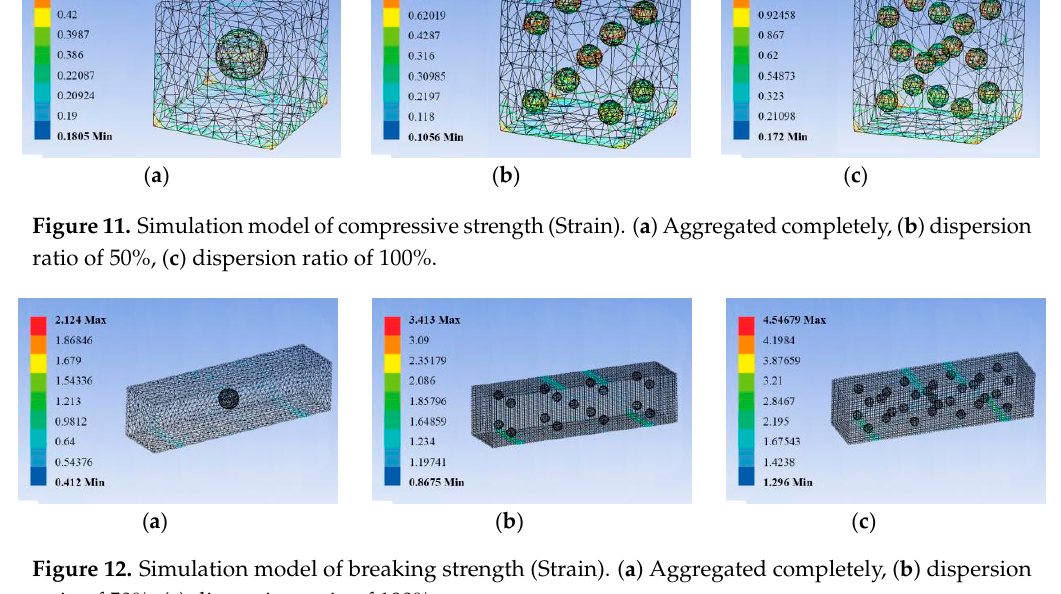
Figure 12. Simulation model of breaking strength (Strain). ( a ) Aggregated completely, ( b ) dispersion ratio of 50%, ( c ) dispersion ratio of 100%.